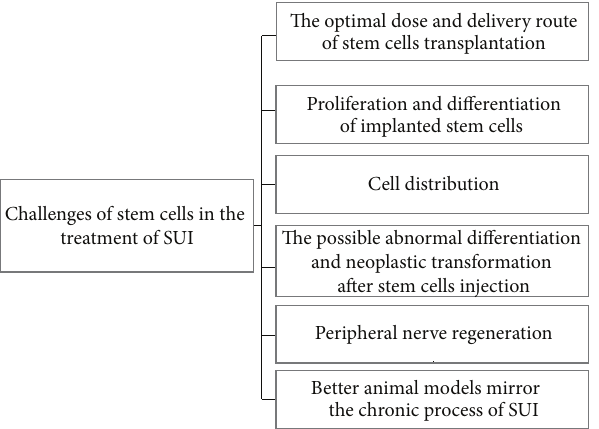
Figure 3: The challenges of stem cells in the treatment of stress urinary incontinence. There are many challenges for stem cells in clinical treatment of SUI, the following facts were shown: (a) an important step to determine the optimal dose and delivery route of stem cells transplantation; (b) how to maintain or promote the abilityofproliferationanddifferentiationofimplantedstemcells;(c) the injected stem cells’ tendency to gather around the injection site and how to form a uniform cell distribution after stem cell injection; (d) stem cells implantation having the risk of neoplastic transforma- tion and how to avoid the possible abnormal differentiation, even neoplastic transformation, after stem cells injection; (e) peripheral nerve regeneration after stem cell transplantation; (f) better animal models that mirror the chronic process of SUI which should be used in preclinical